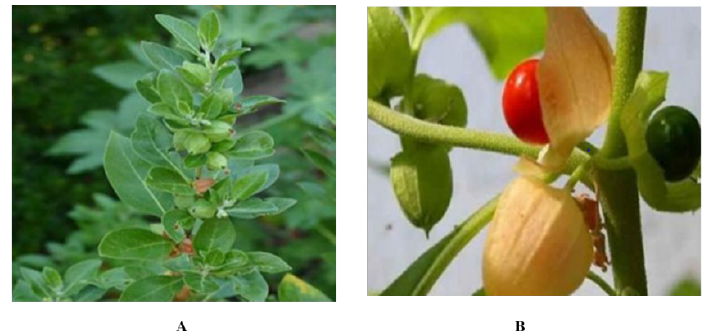
Figure 1. Withania somnifera ( A ) Plant ( B )